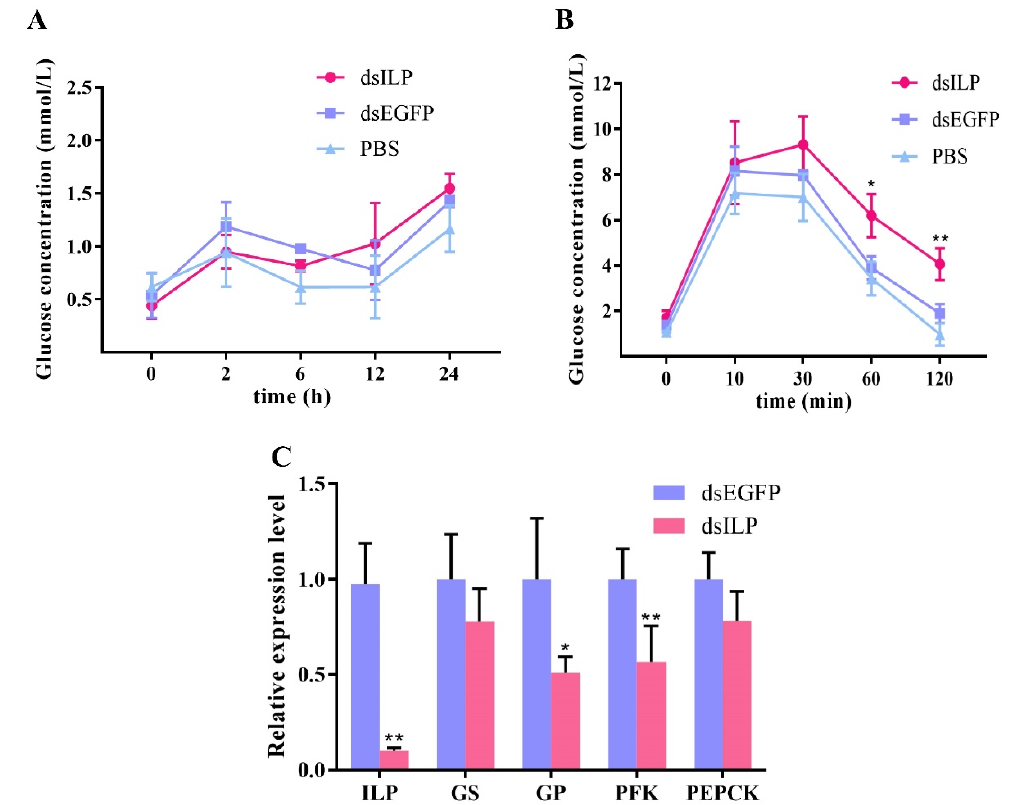
Figure 5. Effects of LvILP interference on hemolymph glucose and the expressions of glucose metabolism genes. ( A ) The variation curve of hemolymph glucose concentration within 24 h after RNAi of LvILP . ( B ) The variation curves of hemolymph glucose concentration within 2 h after glucose was injected into the LvILP RNAi shrimp. ( C ) The expression levels of LvILP and the glucose metabolism genes at 24 h after dsLvILP injection. Error bars indicate the mean ± SD of three replicate samples. Statistical significances are shown as * p < 0.05 and ** p < 0.01.